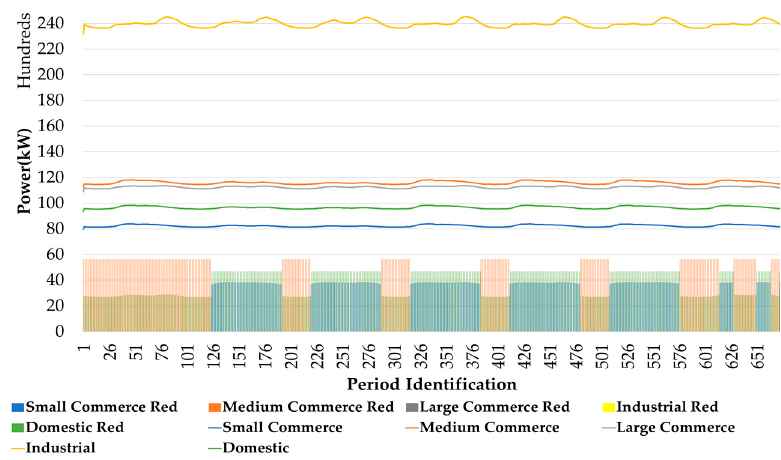
Figure 2. Results from optimization for the different DG units—sum of all units from each type.